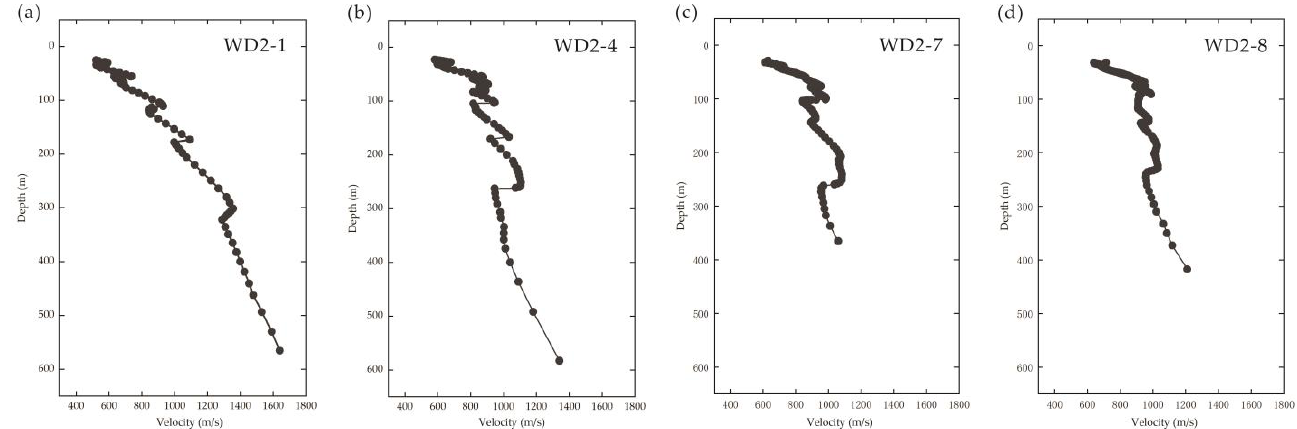
Figure 11. D-V curves of each measurement point of WD2 line: ( a ) the DV curve of WD2-1; ( b ) the DV curve of WD2-4; ( c ) the DV curve of WD2-7; and ( d ) the DV curve of WD2-8.